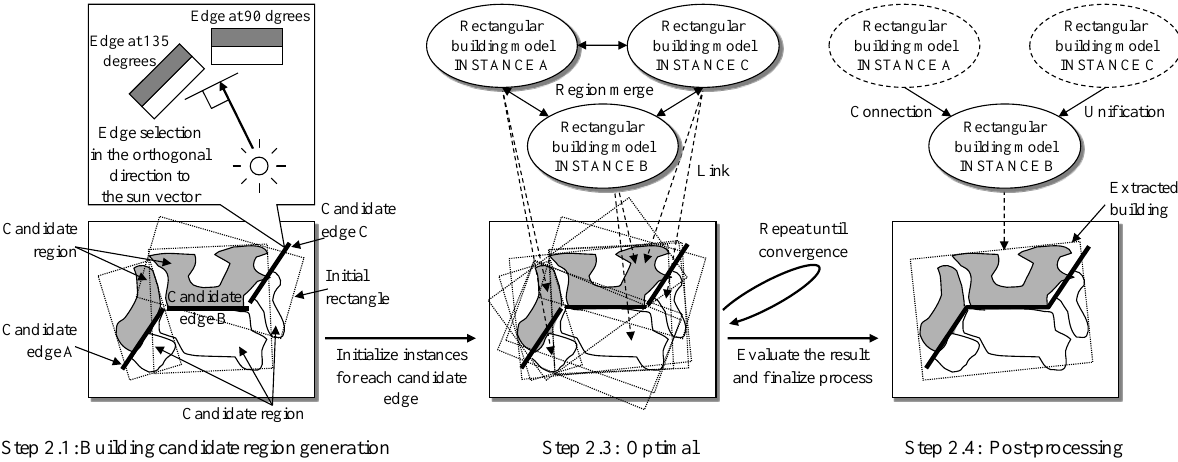
Figure 7. Newly-built building extraction